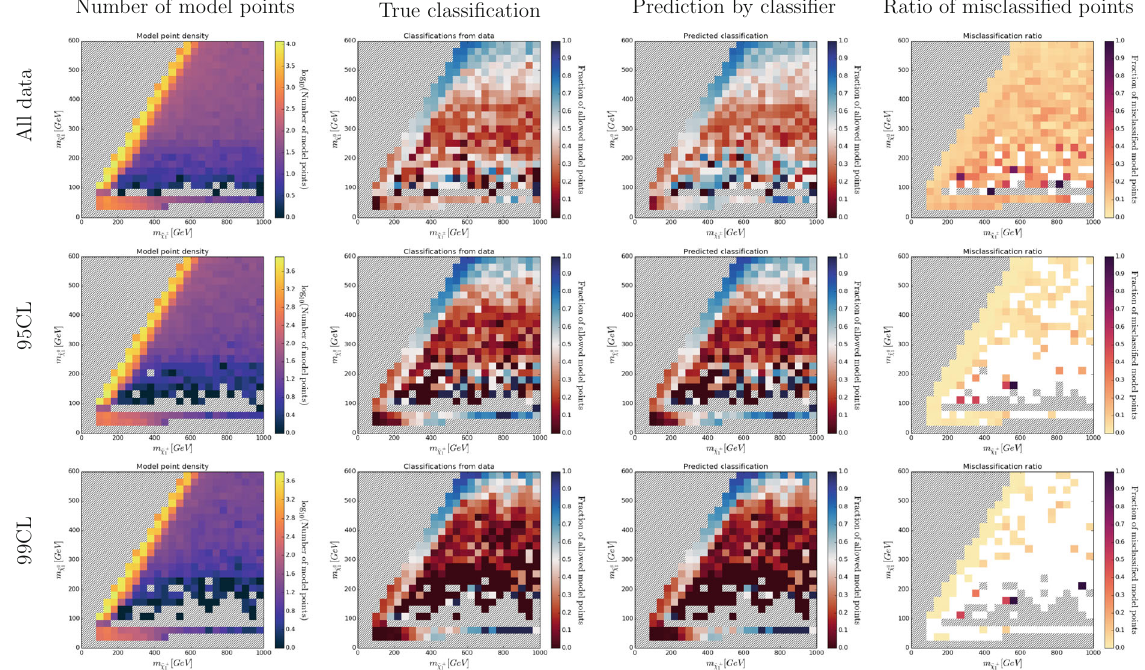
Fig. 15 Color histograms for a projection of the 19-dimensional pMSSM parameter space on the m ˜ χ 0 in the second and third column indicates the fraction of allowed data points for the true classification and the out-of-bag